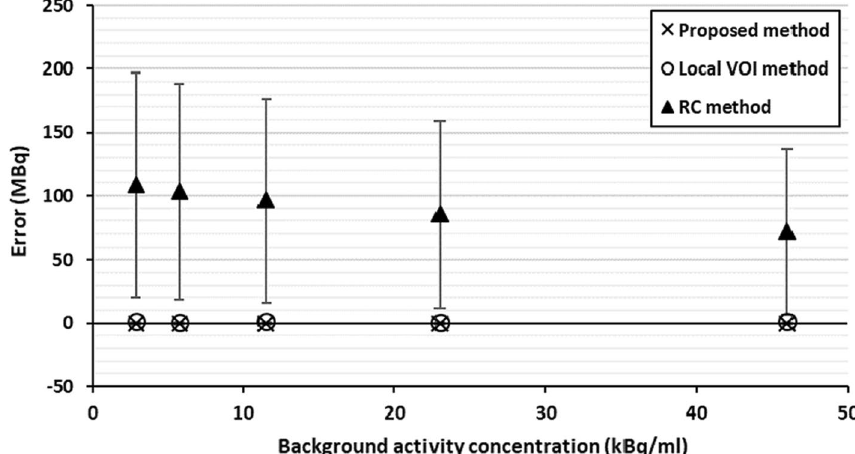
Fig. 5 Absolute errors for the five sources to background ratios and associated uncertainties using the proposed method, RC method and local VOI